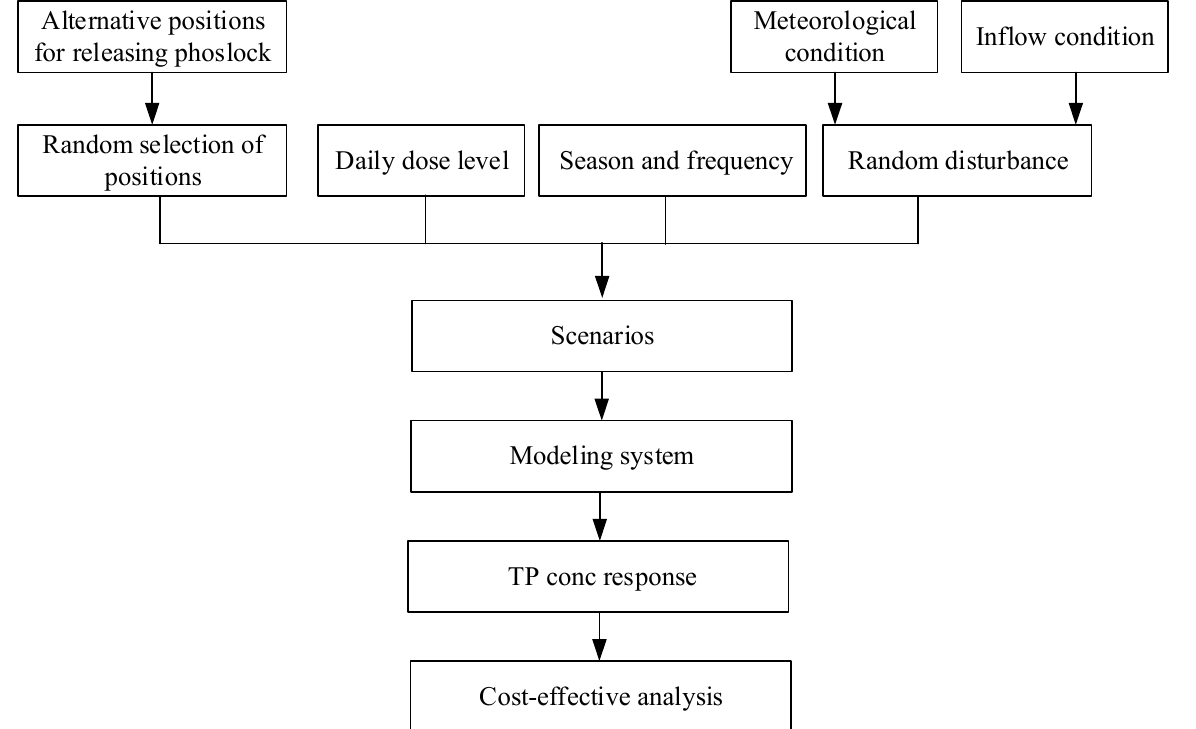
Figure 1. Flowchart of object-oriented intelligent engineering design (OOID)-Phoslock framework.